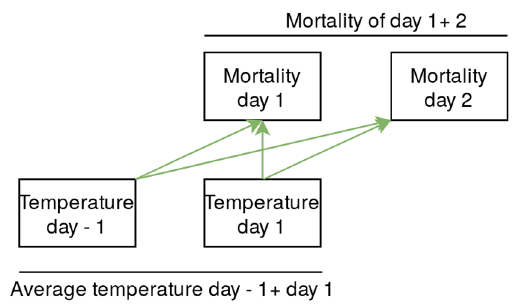
Figure 3. Association between two-day average of temperature and two-daily mortality, with consideration of lag effects avoiding a leading connection between day-1-mortality and day-2-temperature.